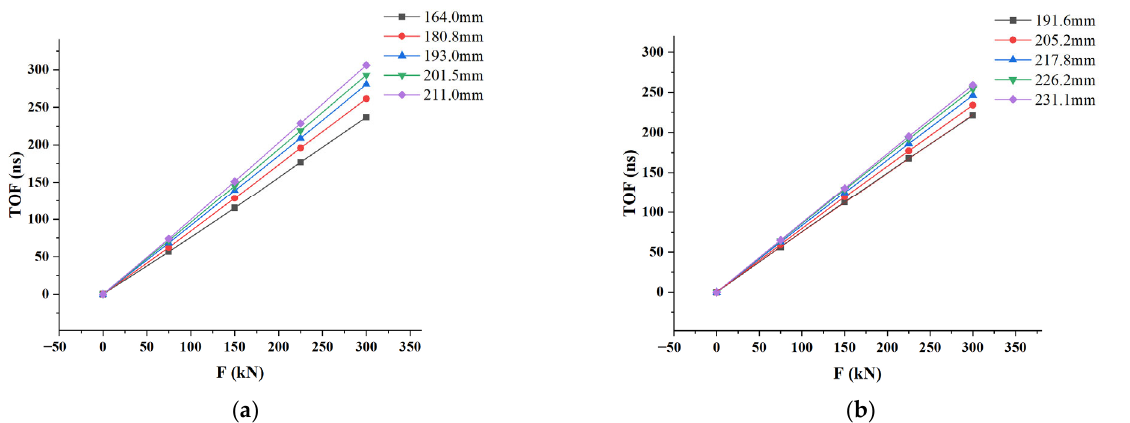
Figure 6. Relationship between ∆ t and the axial load under different clamping lengths for ( a ) M42 bolt; ( b ) M48 bolt.